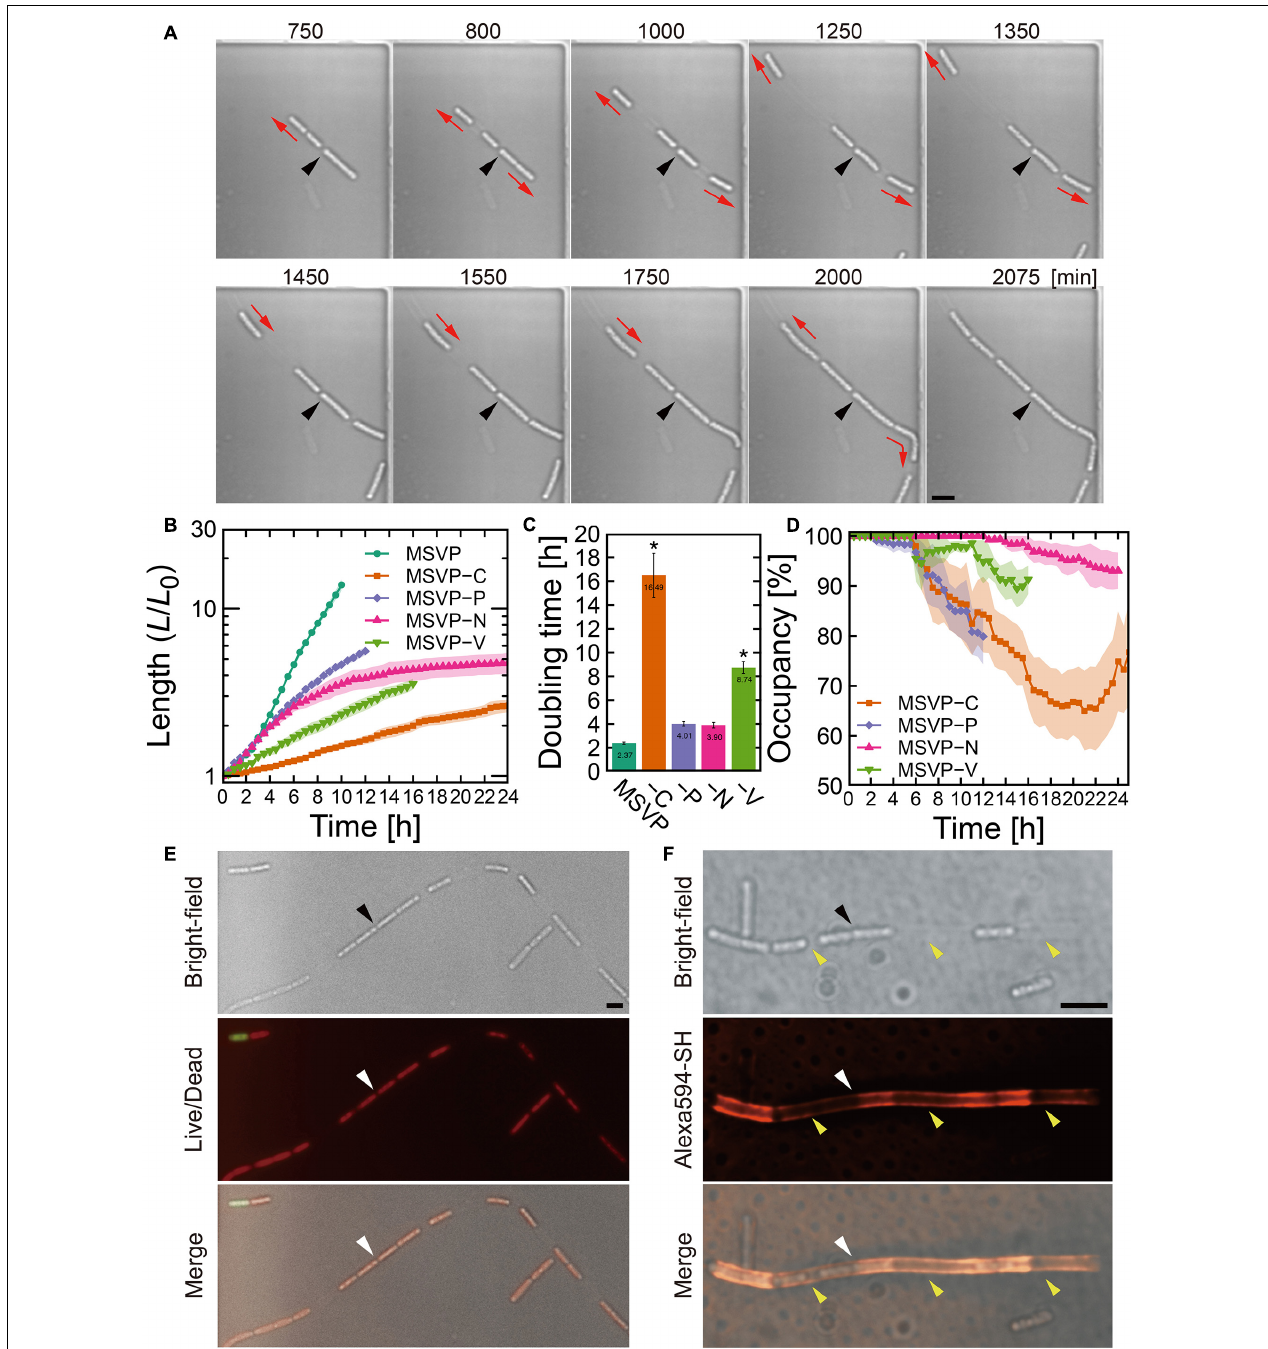
FIGURE 2 | Cell filament elongation in the patchy mode. (A) Time-lapse image sequence showing filamentous growth in MSVP-C. Initial surface attachment of the cells is defined as t = 0. Black arrowheads indicate the same spatial position in each frame and red arrows indicate the direction of the cell filament elongation. (B) Summed length of all cells in the filament measured from three independent cell filaments normalized by their initial length and grown in MSVP, MSVP-C, MSVP-P, MSVP-N, and MSVP-V. Filled region represents one SD from three experiments. (C) Doubling time during exponential growth in MSVP, MSVP-C, MSVP-P, MSVP-N, and MSVP-V. The error bars represent the SD ( n = 3). The significant difference compared to growth in MSVP is caluculated using Dunnet’s test ( n = 3, * P < 0.002). (D) Average occupancy (dotted line) and SD (filled region) of three independent filaments filled with cells as a function of time when grown on MSVP-C, MSVP-P, MSVP-N, and MSVP-V. (E) Live/dead cell labeling. Red fluorescence labels live cells while green fluorescence labels dead cells. (F) Fluorescent labeling of the sheath in MSVP-C. Black and white arrowheads in (E,F) indicate the same spatial positions in each frame, while yellow arrowheads in (F) indicate the positions of wide intercellular gaps. Scale bars = 5 µ